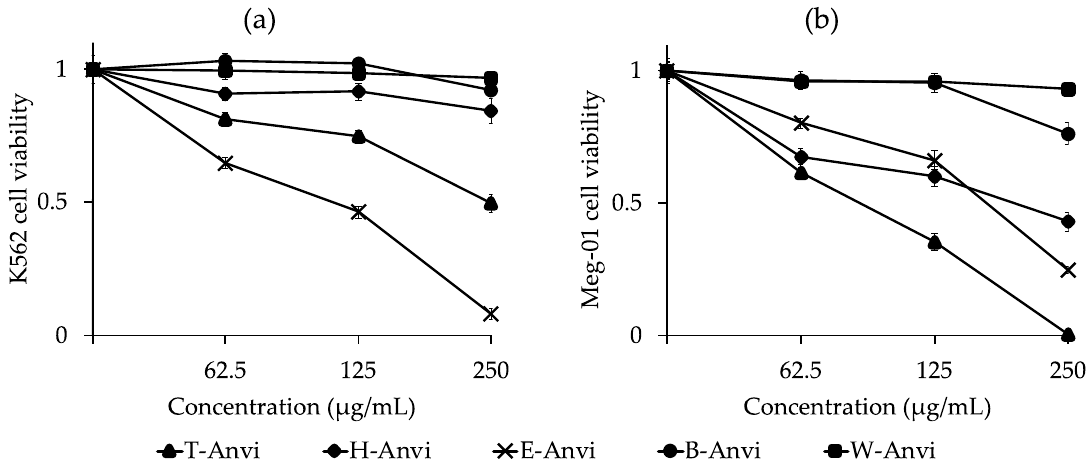
Figure 3. Dose-response curves of A. virginicus extracts for cytotoxicity against ( a ) K562 and ( b ) Meg-01 cell lines. T-Anvi, total crude extract; H-Anvi, hexane extract; E-Anvi, ethyl acetate extract; B-Anvi, butanol extract; W-Anvi, water